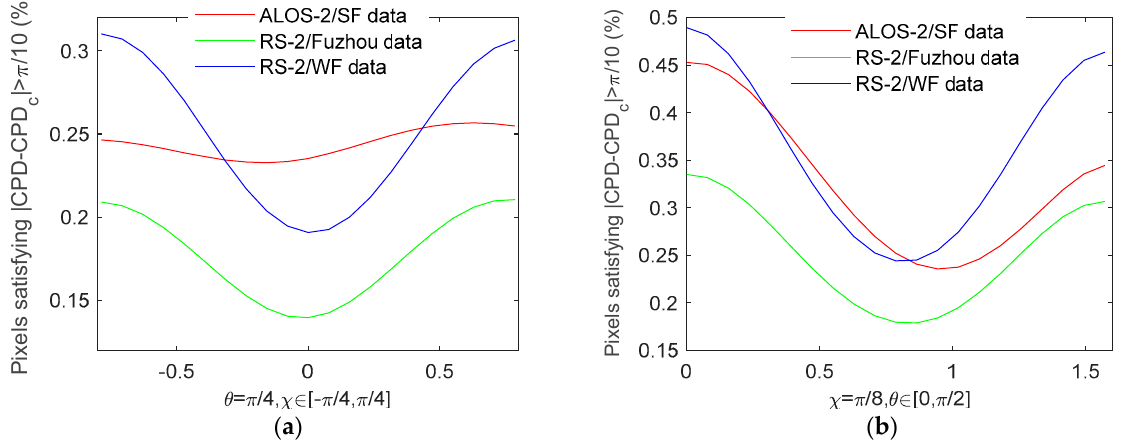
Figure 7. Variation of the percentage of pixels that deviate from the perfect reconstruction by 5% with the varying CP modes. ( a ) The CP mode with | x | = | y | . ( b ) The CP mode with | x | (cid:54) = | y | . Remote Sens. 2021 , 13 , x FOR PEER REVIEW